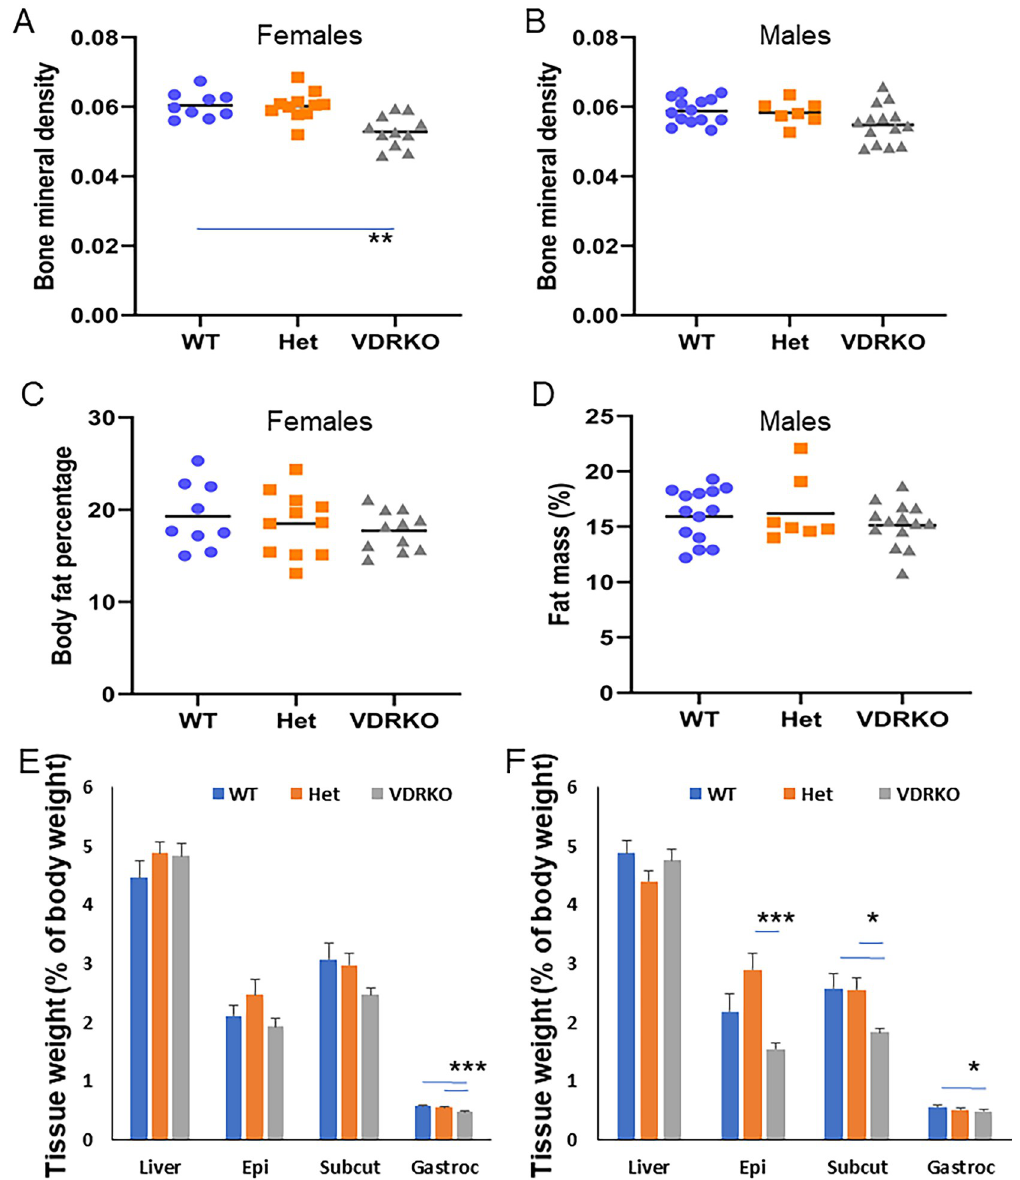
Fig 4. Body composition measures. A) Bone mineral density in female mice. B) BMD in male mice. C). Body fat percentage measured by DEXA in female mice. D) Body fat percentage in male mice. E) Tissue weights in female mice, expressed as percent of body weight. F) Tissue weights in male mice. Epi = epigonadal fat. Subcut = subcutaneous fat. Gastroc = gastrocnemius. � = p < 0.05, �� p < 0.01 and ��� = p < 0.001 for the indicated comparison. All p-values are corrected for multiple comparison (Bonferroni). N � 9 mice per